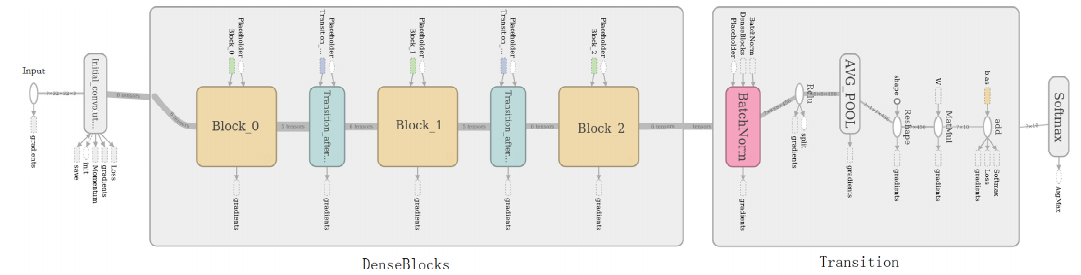
Figure 2. DenseNet ‐ 40 (DenseNet with 40 layers) architecture for CIFAR with three dense blocks and a global average pool layer. The squares in DenseBlocks represent the three dense blocks. The rounded rectangle with the label AVG_POOL in Transition represents the global average pool layer.